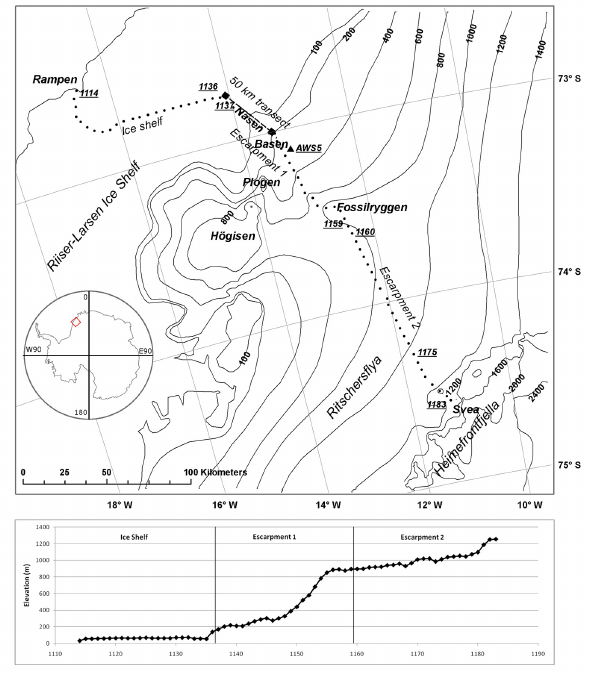
Fig. 1. Map of the research area and profile of elevation for the 310- km-long transect. Each measurement site along the transect is iden- tified by the code 11 followed by a progressive mass balance stake number, from 14 at the coast to 83 at the innermost site (sites 1114, 1136, 1137, 1159, 1160, and 1183 are marked in the map). The region marked as Ice shelf extends from 1114 to 1136, the Escarp- ment 1 from 1137 to 1159, and Escarpment 2 from 1160 to 1183. The crosses mark the locations of the Basen and Svea